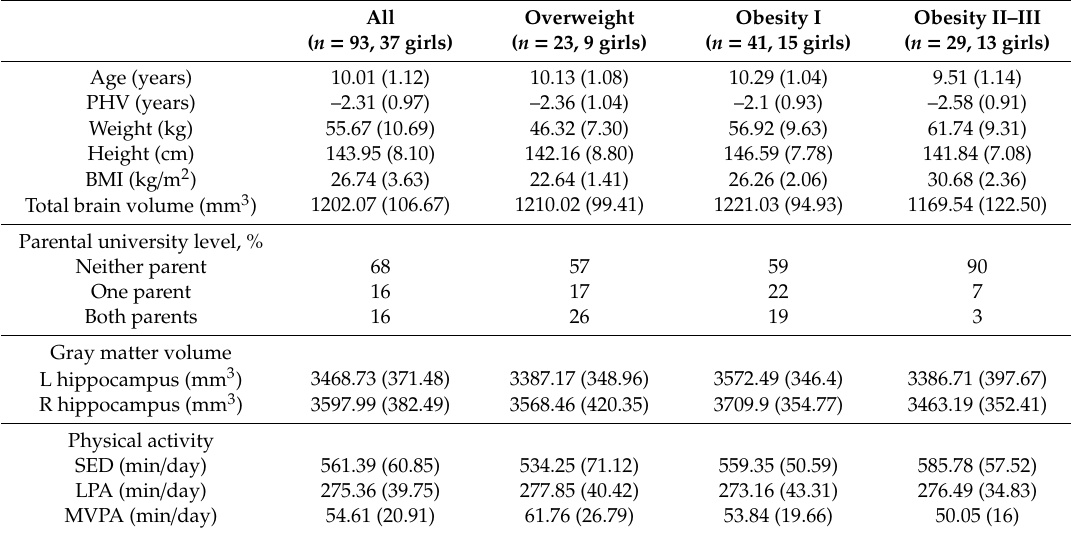
Table 1. Descriptive characteristics of